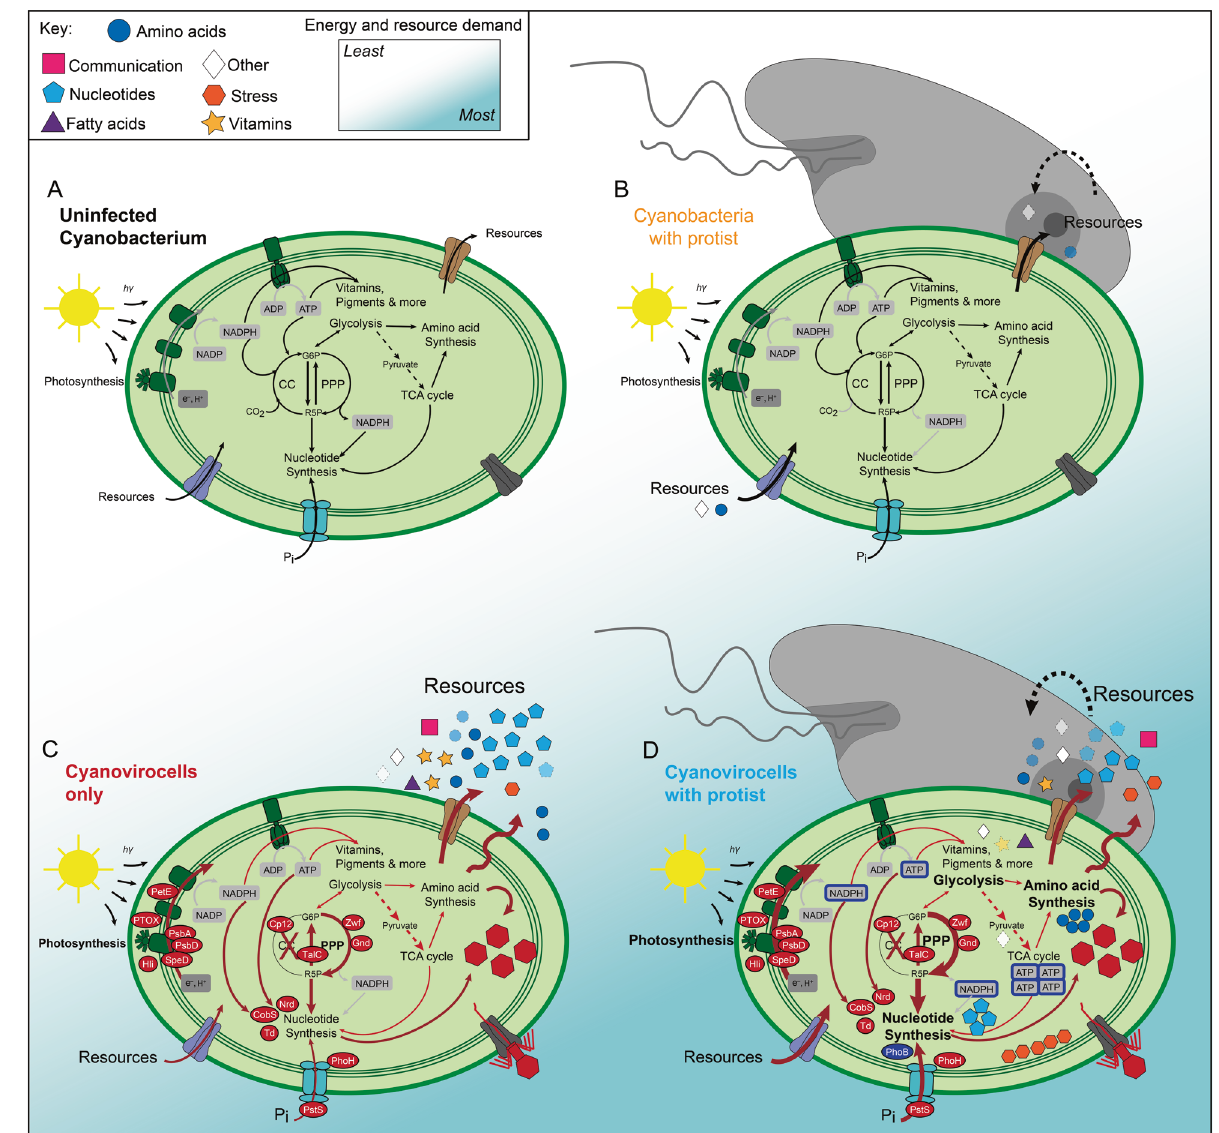
Fig. 6 Metabolic reprogramming and ecosystem impact of protist- and/or phage-treated Synechococcus . A Uninfected cyanobacterium. B Cyanobacteria with protist. The presence of the protist alters the abundance of some exometabolites. C Cyanovirocells only. Cyanophages reprogram P-acquisition, photosynthesis, energy pathways, and nucleotide metabolism toward building new phages. D Cyanovirocells with protist. The energy (e.g., ATP) and resource (e.g., reducing power, phosphate, nucleotides, and amino acids) demand of phage infection is highest for the cyanovirocells co-cultured with a protist. Cyanovirocells have the largest changes in the exometabolites as seen from the release of nutrients, either via diffusion or active transport across the membrane ( C , D ). This nutrient pool is available for the ecosystem, including uptake by protists ( D